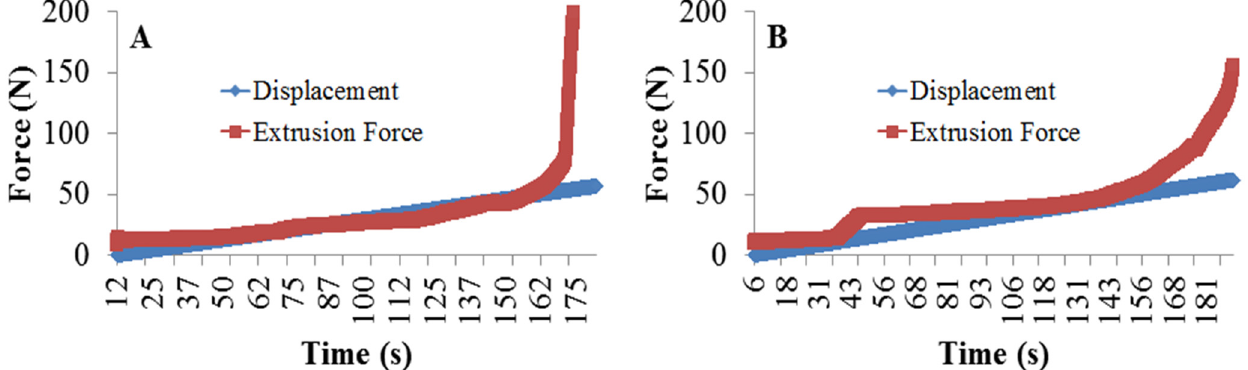
Figure 2. The extrusion force monitored over time for ( A ) composite bone substitute (CBS) 50 40% filled compositions demonstrating a lack of clumping evidenced by uniform stress required to extrude the material from its cartridge; and ( B ) CBS 50 50% filled compositions demonstrating clumping evidenced by the increased extrusion force in the first third of the experiment.